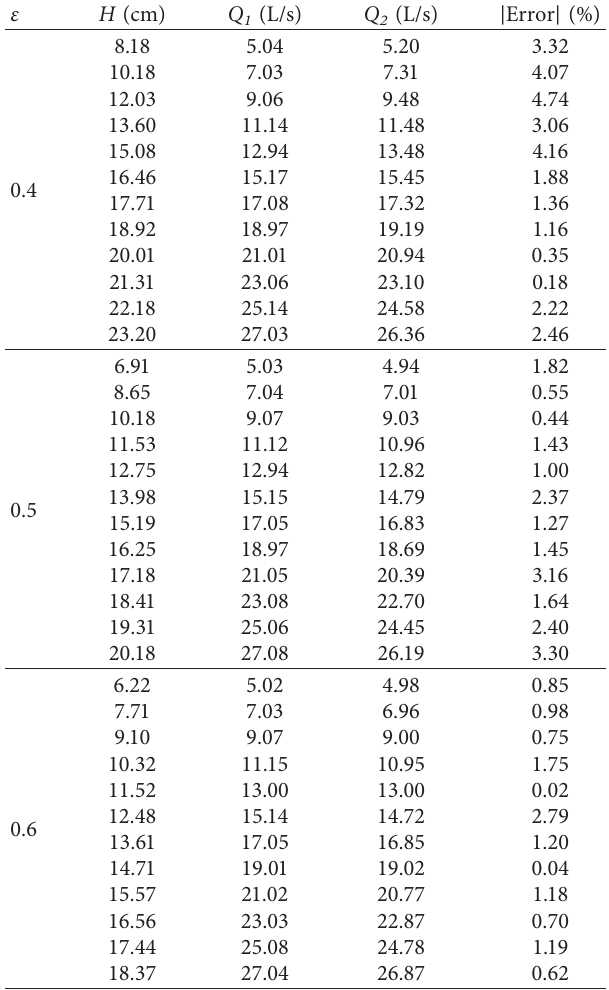
Table 3: Comparison of the measured and calculated flow rates at different contraction ratios.